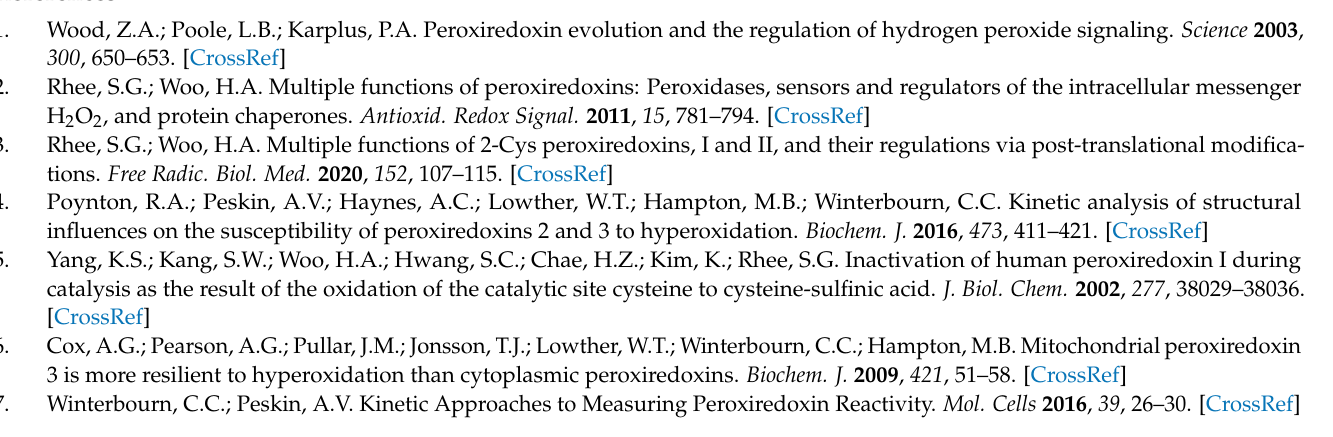
Figure S7: Analysis of the locomotor activity in the srx